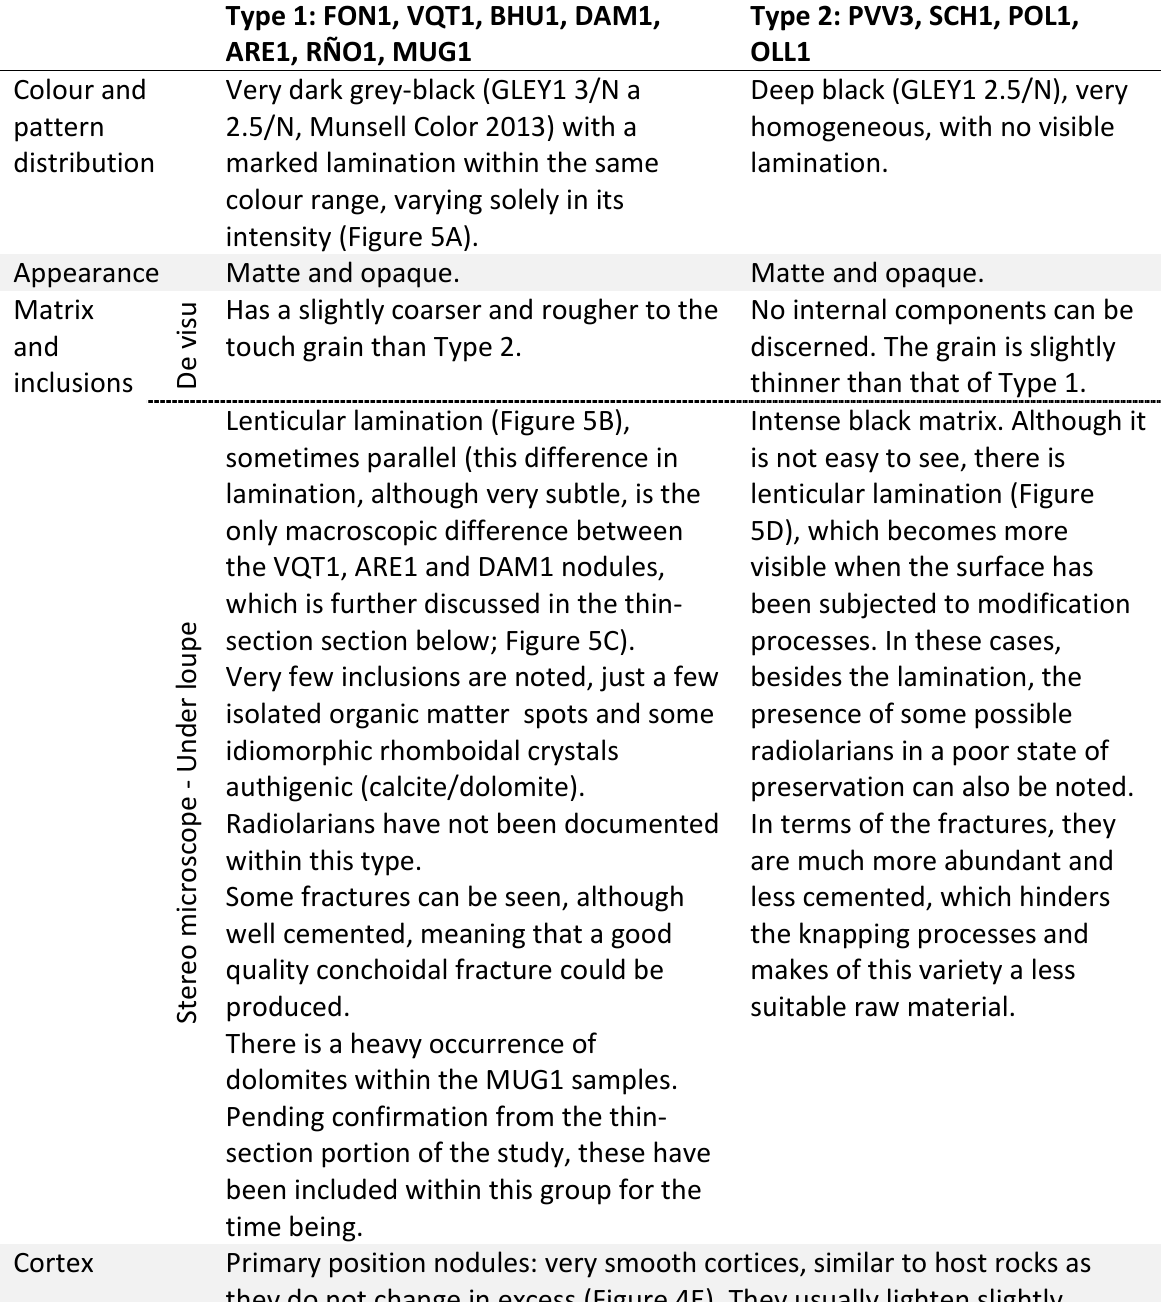
Table 2: Macroscopic characteristics of the analysed